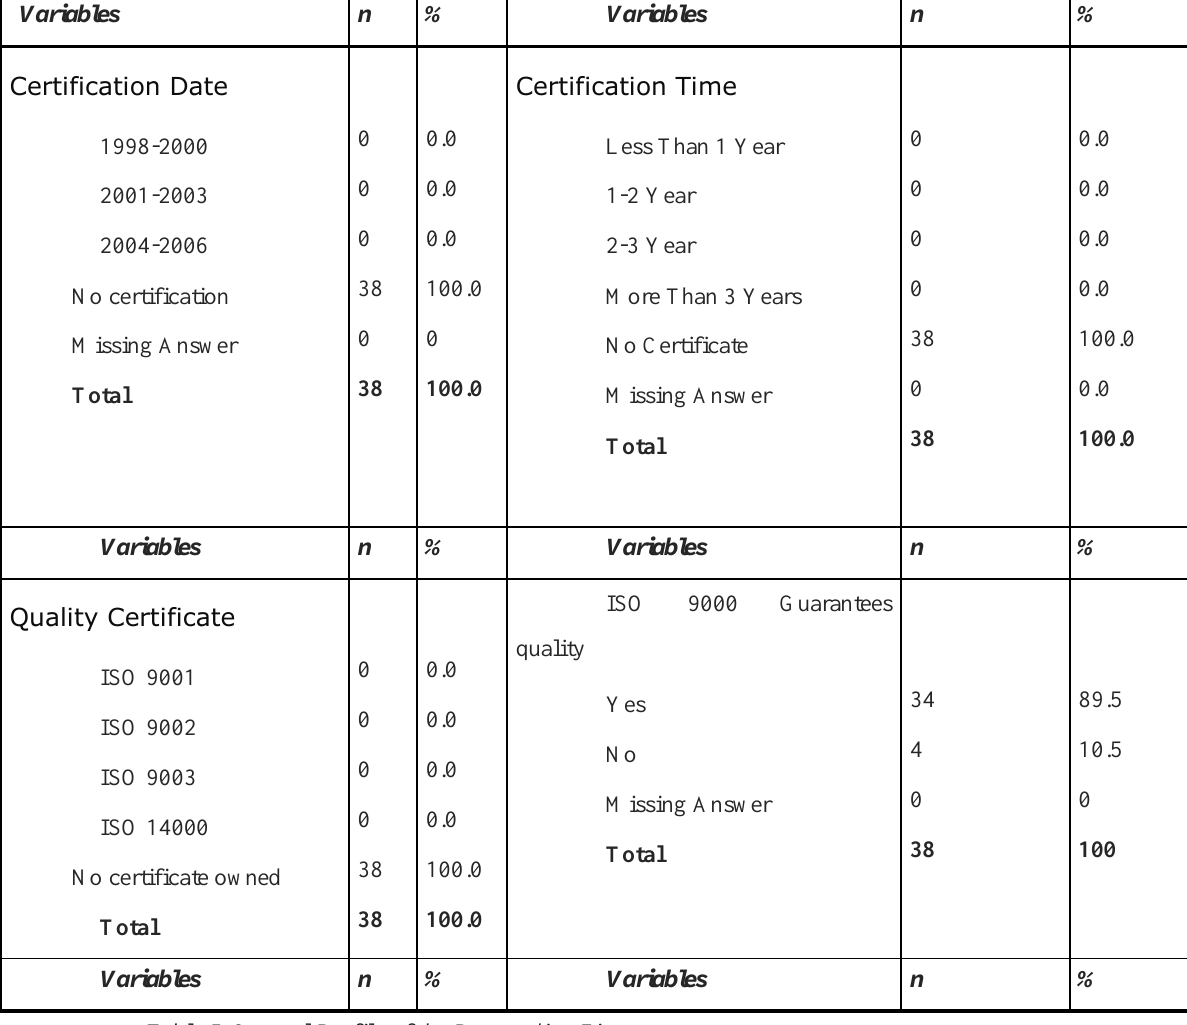
Table I: General Profile of the Responding Firms